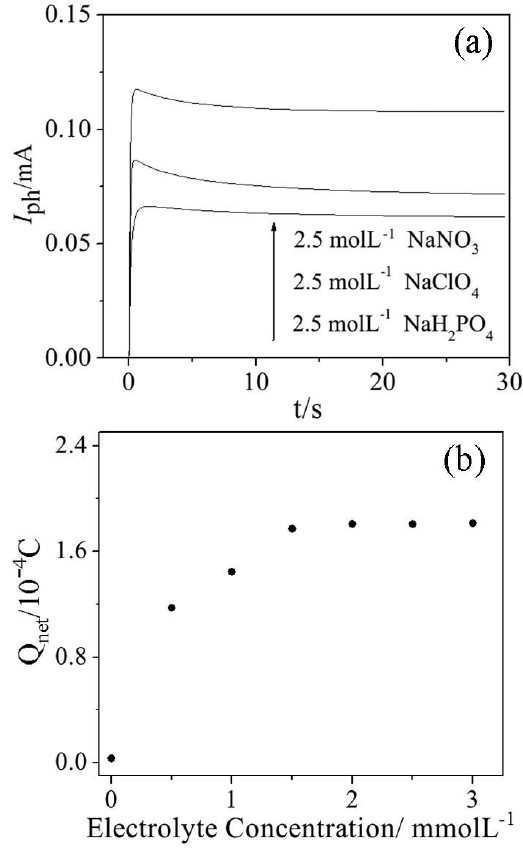
Figure 4. ( a ) Photocurrent responses of different electrolyte solutions without organic; ( b ) Effect of electrolyte concentrations on Q net